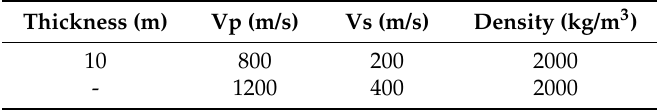
Table 1. The parameters of Model